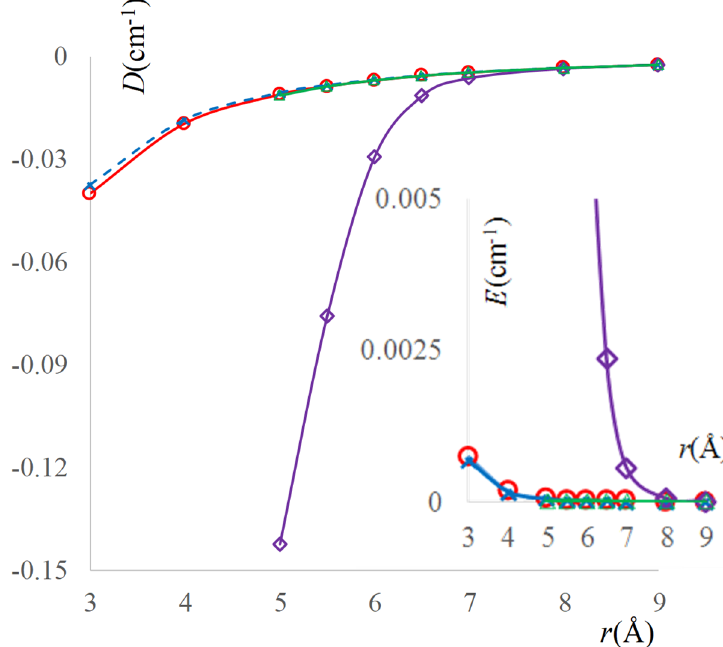
Figure 9. The Zero Field Splitting (ZFS) parameters computed for Configuration 2, as function of separation between the oxygen atoms of the colinear NO groups. The main panel shows the variation of the D parameter for: two TEMPO molecules in vacuum (red line and open circles); with SCRF solvent option (dashed light blue lines and × symbols); two TEMPO molecules with a CH 2 Cl 2 solvent in between, having the CCl 2 and NO ... Cl sequences coplanar (Configuration 2.a-violet line and diamond symbols); two TEMPO molecules with solvent oriented with coplanar CH 2 and NO ... H parts (Configuration 2.b-green line and triangle symbols). The inset corresponds to the E parameter, drawn with the same conventions, for the respective symbols. The Configuration 1 shows a very similar variation of D , while the E is rigorously null, by symmetry reasons.